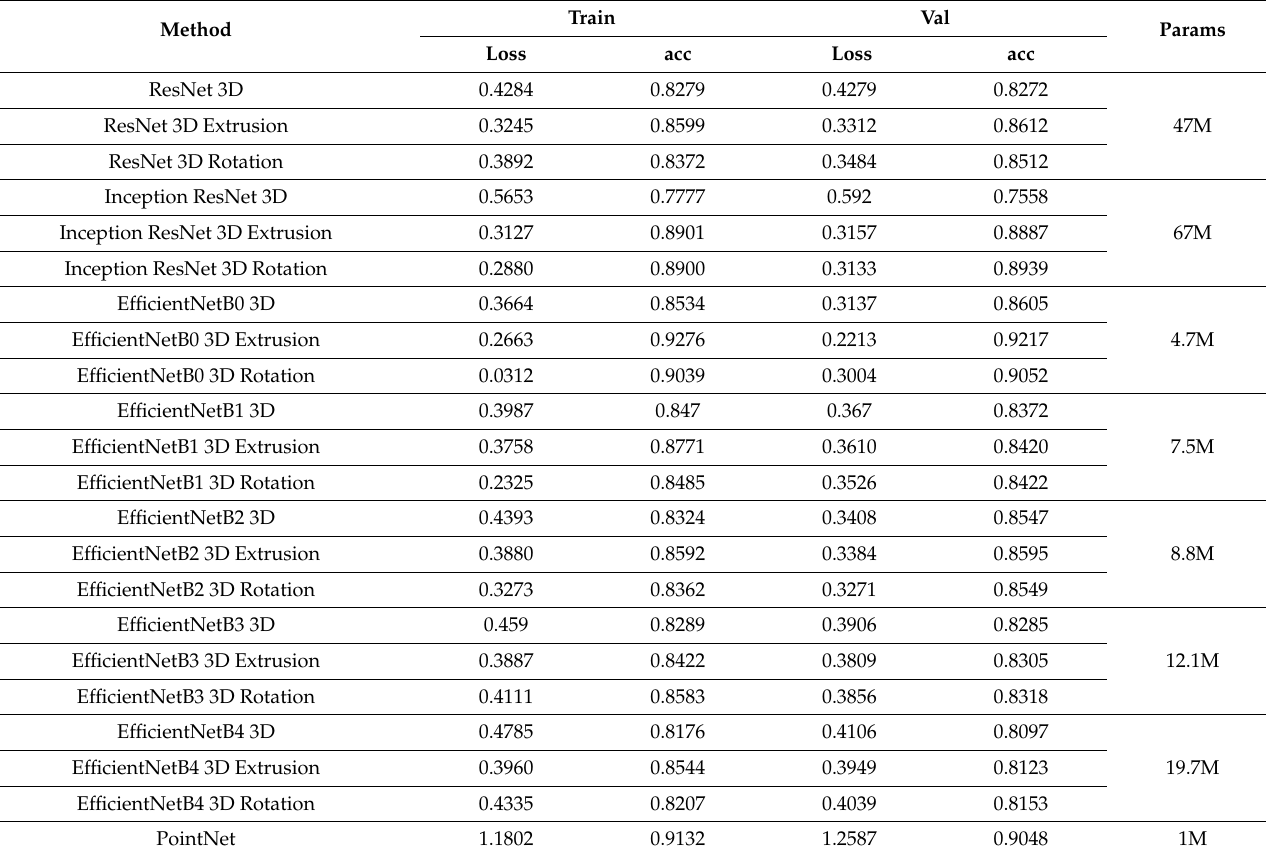
Figure 17. Accuracy on training: PointNet compared to all the architectures initialized with extrusion. Table 4. Accuracy and loss comparative between all the used architectures and PointNet. Last column is the number of parameters each network has to